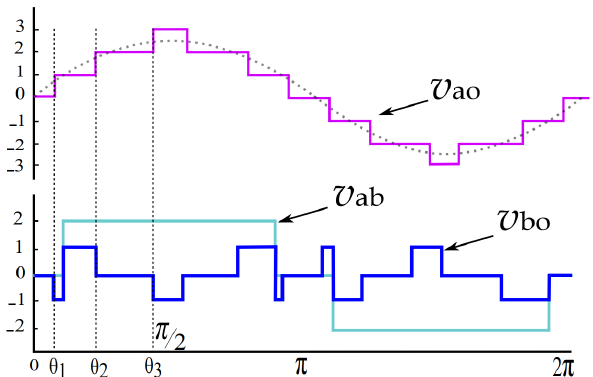
Figure 9. Output voltage of the proposed HMLI topology,Overall output voltage of the inverter ( v ao ), H-bridge output voltage ( v ab ) and CCM output voltage ( v bo